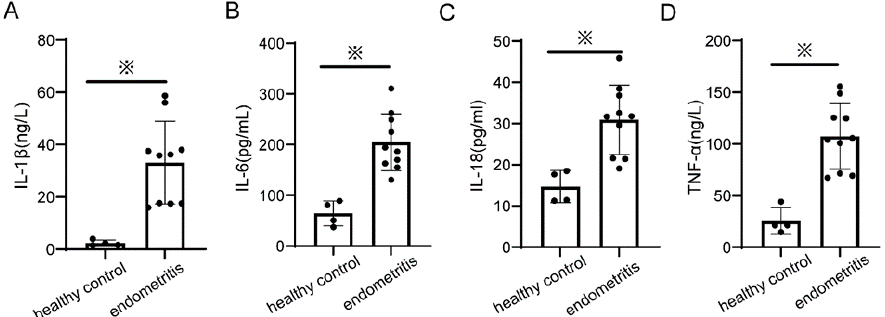
Figure 2. ELISA results from healthy control ( n = 4) endometrial tissue and endometritis group ( n = 10) endometrial tissue, showing levels of ( A ) IL- 1β, ( B ) IL-6, ( C ) IL-18, and ( D ) TNF- α. Values are presented as mean ± SD. ※ p < 0.05. Black points represent individual data points.